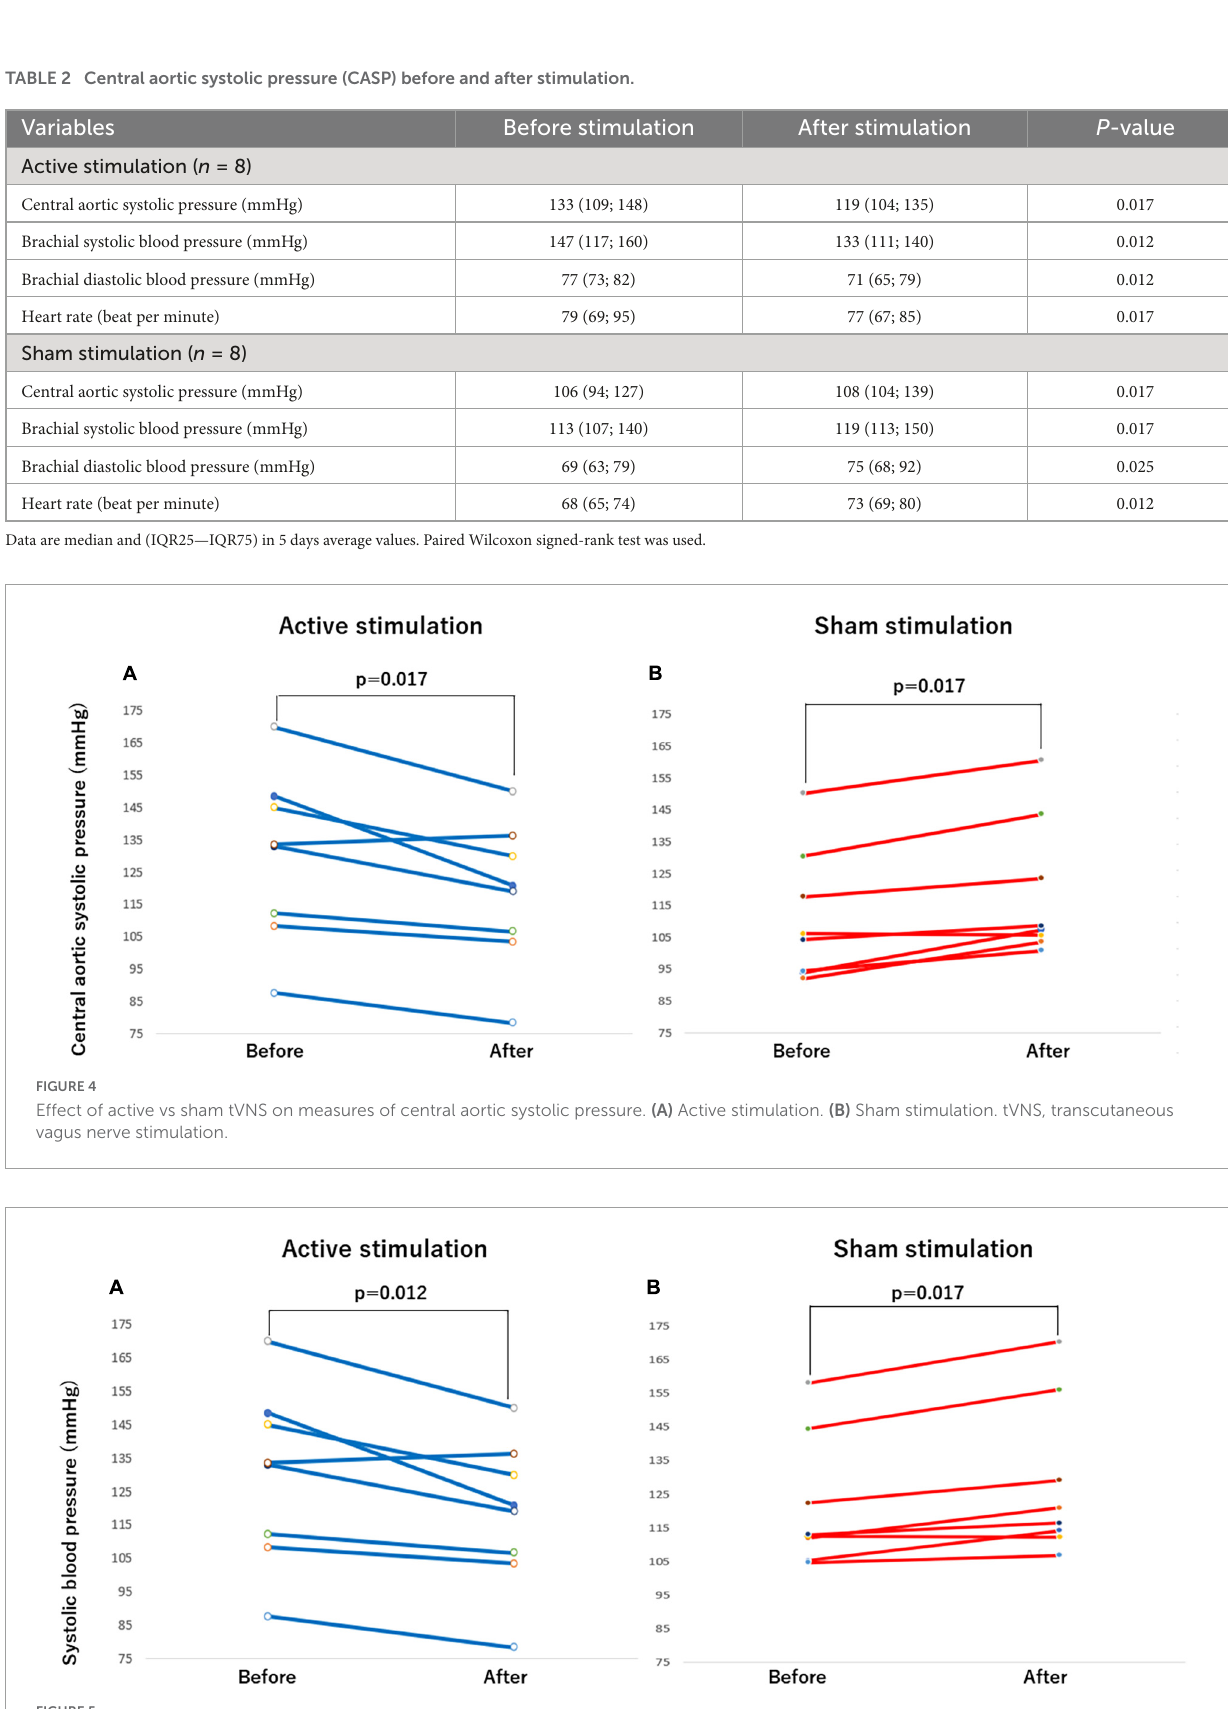
FIGURE5 Effect of active vs sham tVNS on measures of brachial systolic blood pressure. (A) Active stimulation. (B) Sham stimulation. tVNS, transcutaneous vagus nerve